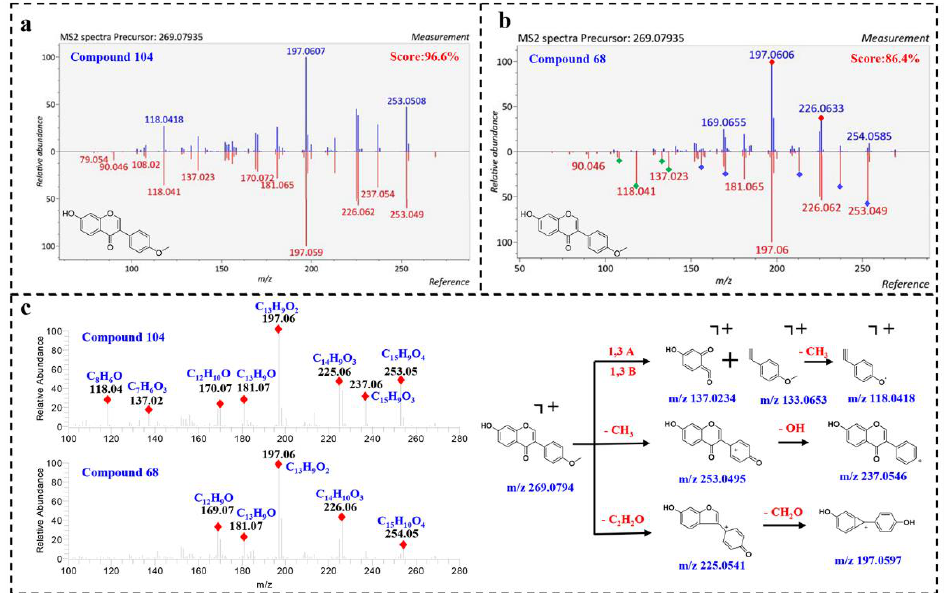
Figure 3. Proposed MS fragmentation pathways of Biochanin B; and matching diagram of compound 104 and 68 in MS-DIAL. ( a ) matching diagram of compound 104 in MS-DIAL; ( b ) matching diagram of compound 68 in MS-DIAL; ( c ) proposed MS fragmentation pathways of Biochanin B.